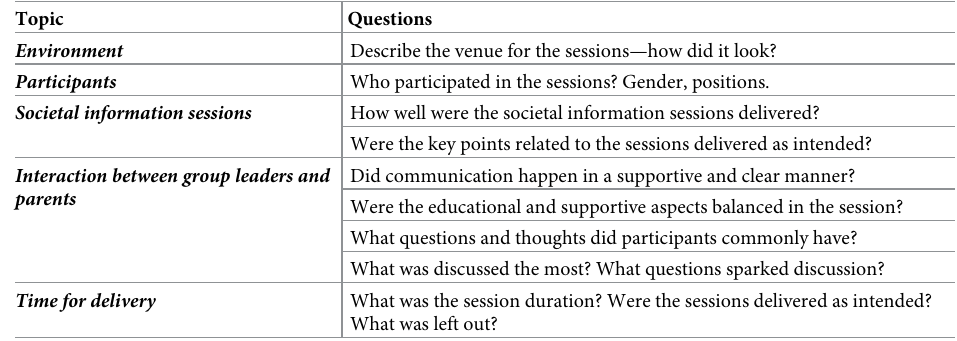
Table 5. Observation and reflection note scheme.